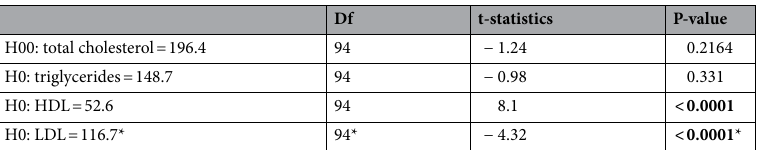
Table 2. One sample t-test results of the weighted lipid profile mean value between MGD group and control group. Df degree of freedom. *Since KNHAES did not conduct an LDL survey in 2012, we calculated the LDL concentration using the Friedewald equation for both group of MGD and control. The bolds stand out for the “statistically significant”.